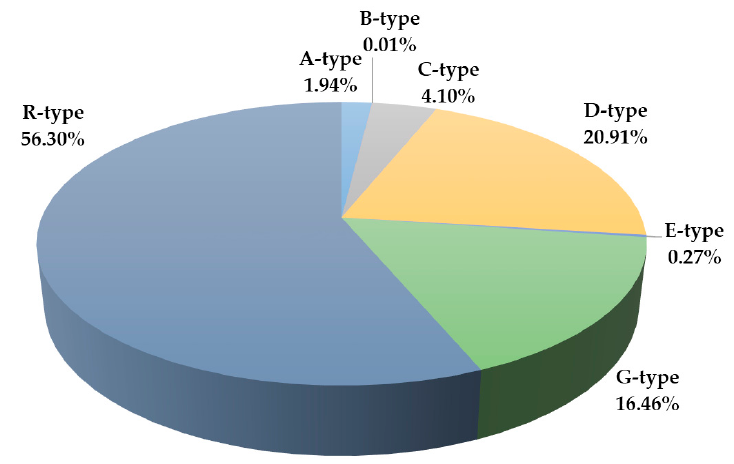
Figure 1. Categories and percentages of industrial waste generation in 2021 [15]. Each category of waste was defined as follows. A-type, manufactured hazardous industrial waste; B-type, industrial waste containing toxic chemical substances; C-type, biomedical/infectious waste; D-type, general industrial waste without recyclable value; E-type, scrap mixed metal; G-type, renewable resource.